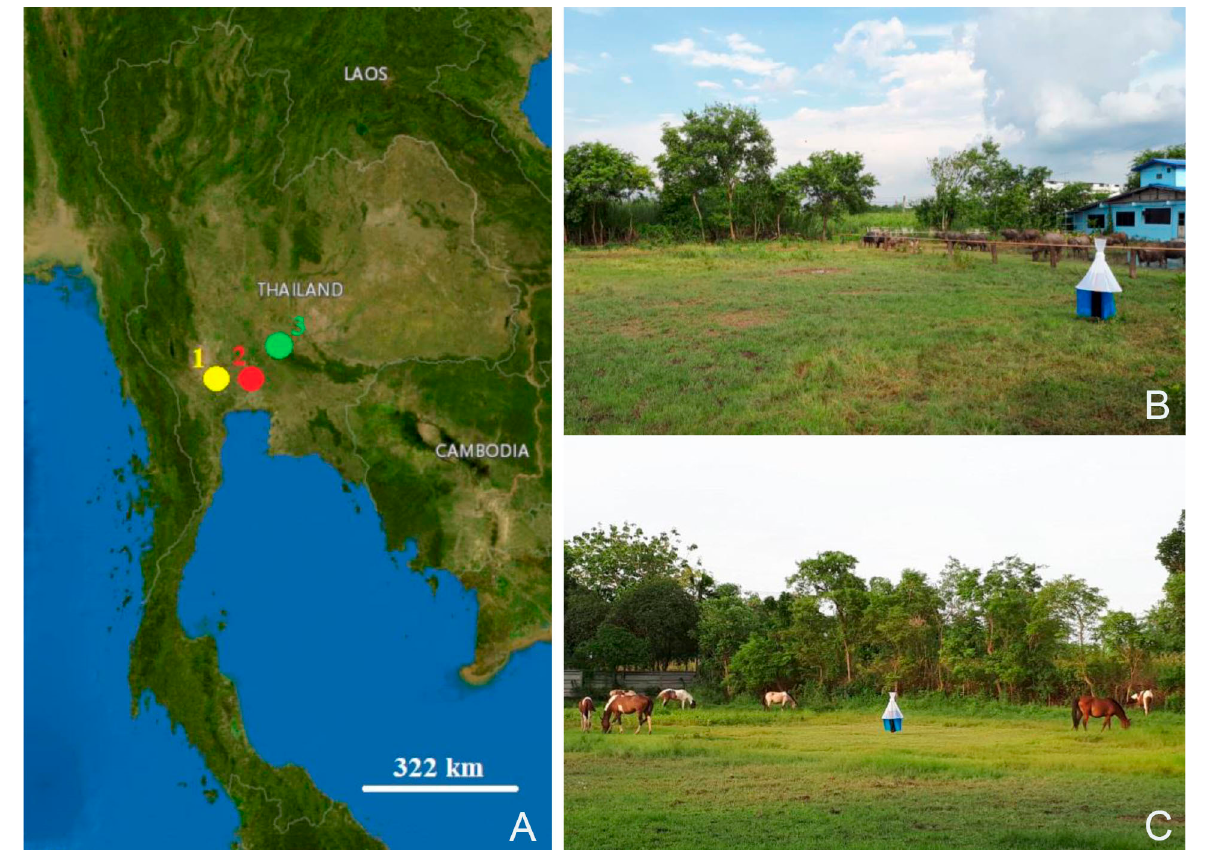
Figure 5. Geographic map of Stomoxys collection sites in this study: Nakhon Pathom (1), Pathum Thani (2), and Saraburi (3) ( A ); Vavoua trap used for fly collection and animal hosts at the collection sites ( B , C ). The map was created using the USGS National Map Viewer (public domain): http://viewer.nationalmap.gov/viewer/, accessed on 8 February 2023. Table 1. Collection sites, month, and number ( n ) of Stomoxys specimens used for the geometric morphometric analysis.